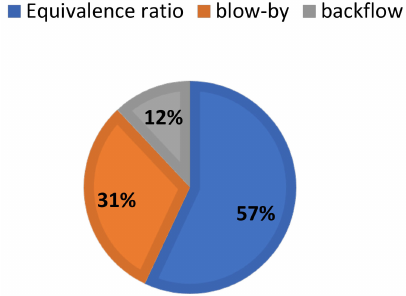
Figure 12. Distribution of particulate emissions during a